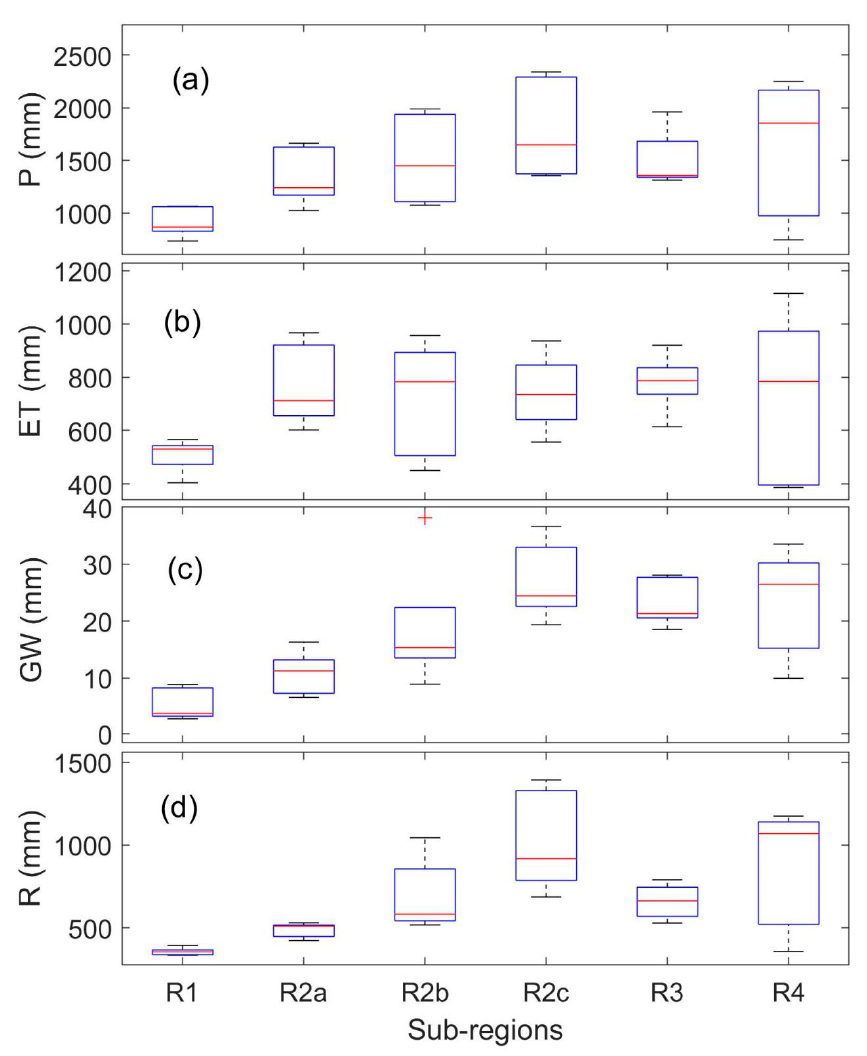
Figure 8. ( a ) Precipitation (P), ( b ) evapotranspiration (ET), ( c ) groundwater recharge (GW) and ( d ) total runoff (R) of the sub-regions obtained from SWAT model simulations for each of the GPPs. Box plots display the 25th, 50th, and 75th percentiles. Table 6. Water balance components of the sub-regions in the Mekong River